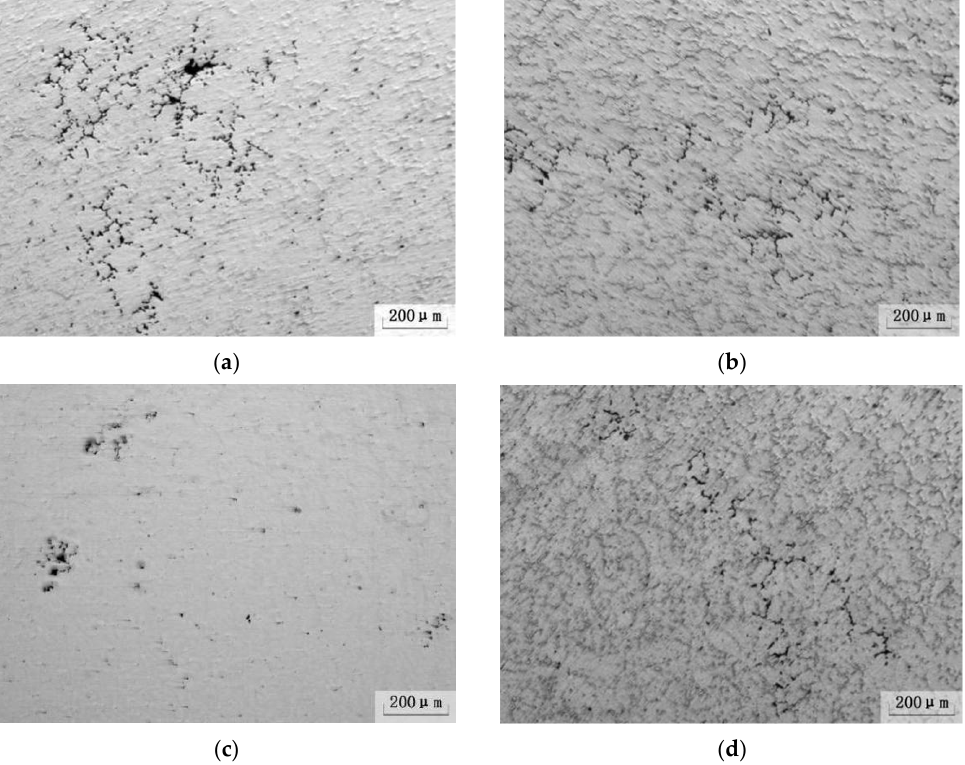
Figure 12. Variation of microporosity in AZ91 alloy by ultrasonic treating time. ( a ) 0 s; ( b ) 30 s; ( c ) 90 s; ( d ) 150 s.